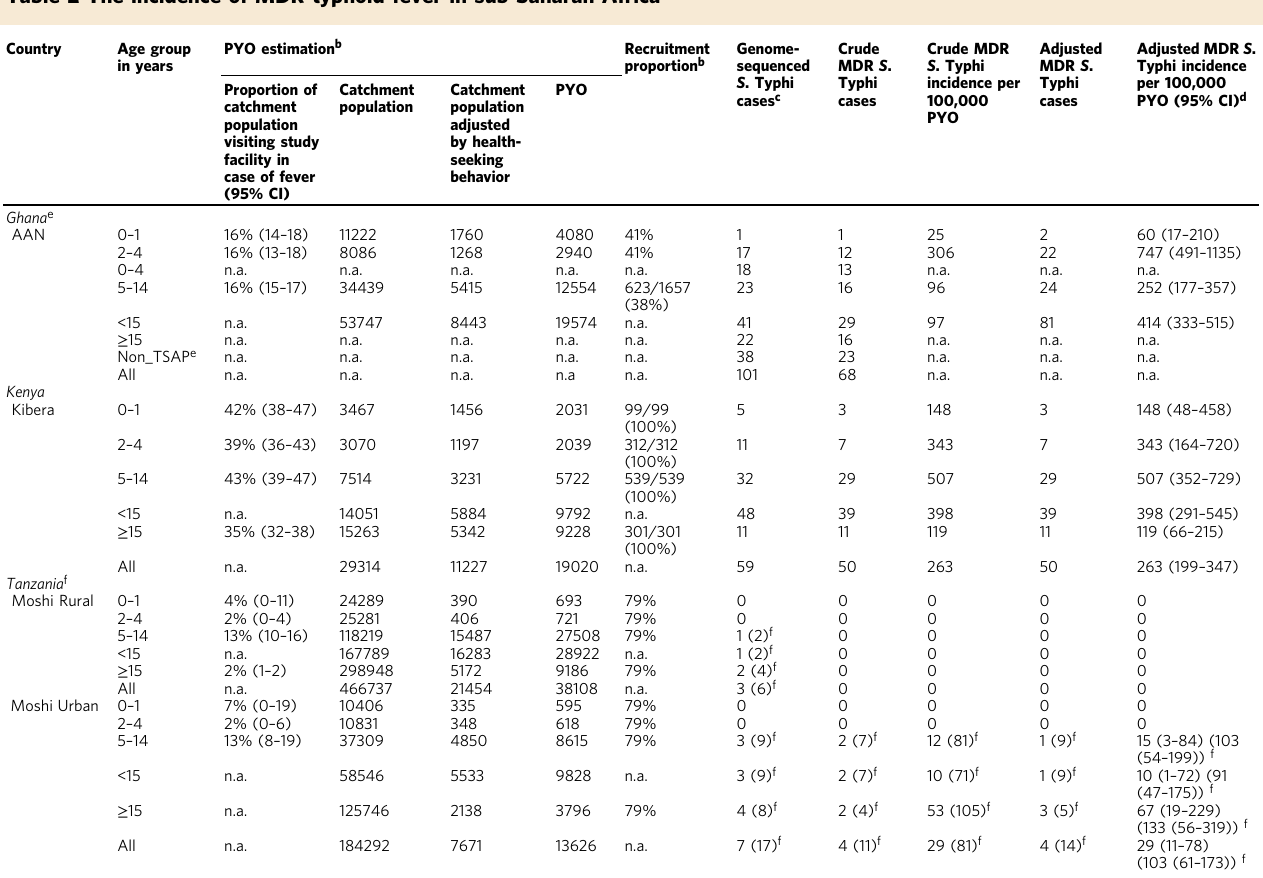
Table 2 The incidence of MDR typhoid fever in sub-Saharan Africa